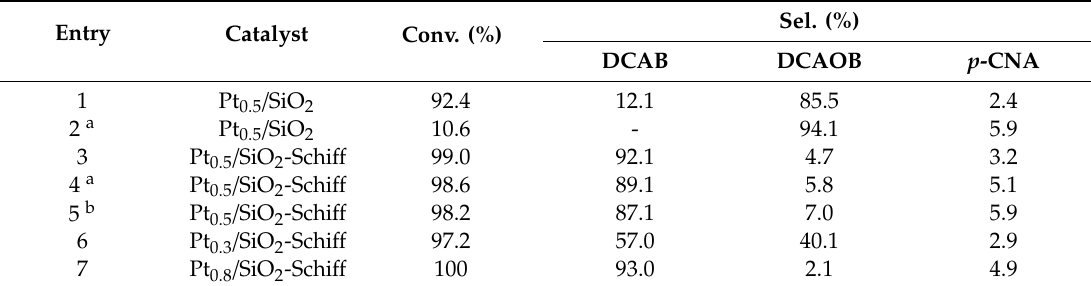
Table 1. Hydrogenation of p -chloronitrobenzene ( p -CNB) to 4,4 ′ -dichloroazobenzene (DCAB) over different catalysts.